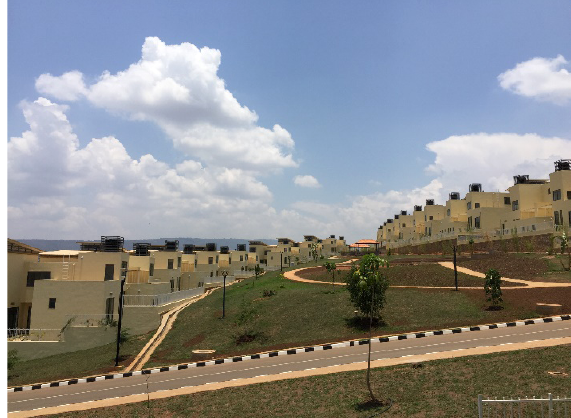
Figure 45. The Umudugudu Kigali Vision main gate. Photograph by Manlio Michieletto.